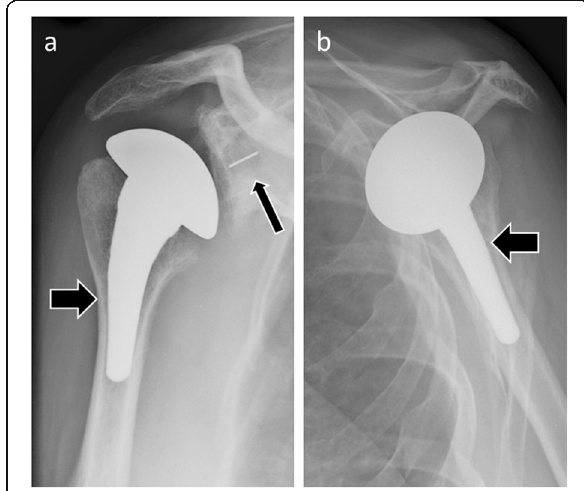
Fig. 3 Anteroposterior ( a ) and scapular Y ( b ) radiographs of normal findings in a patient with total shoulder arthroplasty. The humeral prosthetic stem (thick arrows) is centered within the humeral shaft. The humeral prosthetic head is centered within the glenoid implant (thin arrow), with a smooth arc between the cortex of the